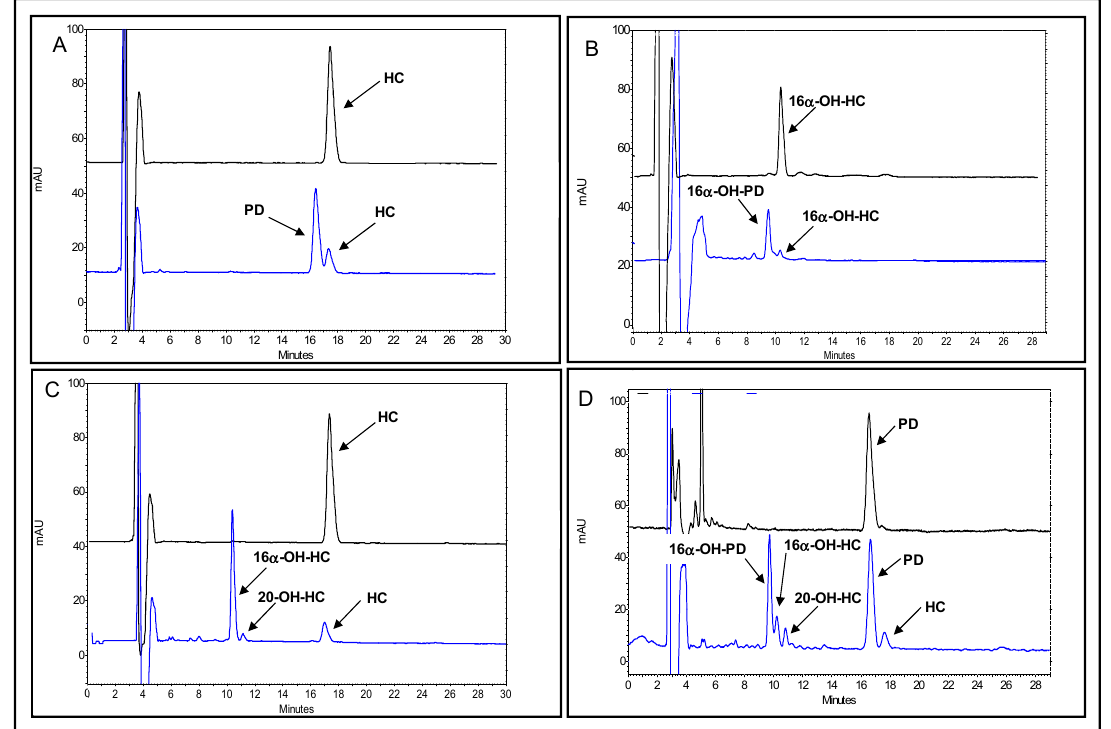
Figure 3. Representative HPLC chromatograms of A. simplex dehydrogenation of hydrocortisone into prednisolone ( A ) and of 16 α -hydroxyhydrocortisone into 16 α -hydroxyprednisolone ( B ) and of S. roseochromogenes hydroxylation of hydrocortisone into 16 α -hydroxyhydrocortisone (and into the by-product, 20-hydroxyhydrocortisone) ( C ) and of prednisolone into 16 α -hydroxyprednisolone ( D ). In this last case, the microorganism also performed a hydrogenation reaction of prednisolone back to hydrocortisone that was then hydroxylated into 16 α -hydroxyhydrocortisone (and into the by-product, 20-hydroxyhydrocortisone) ( D ). All peaks are indicated by the arrows.